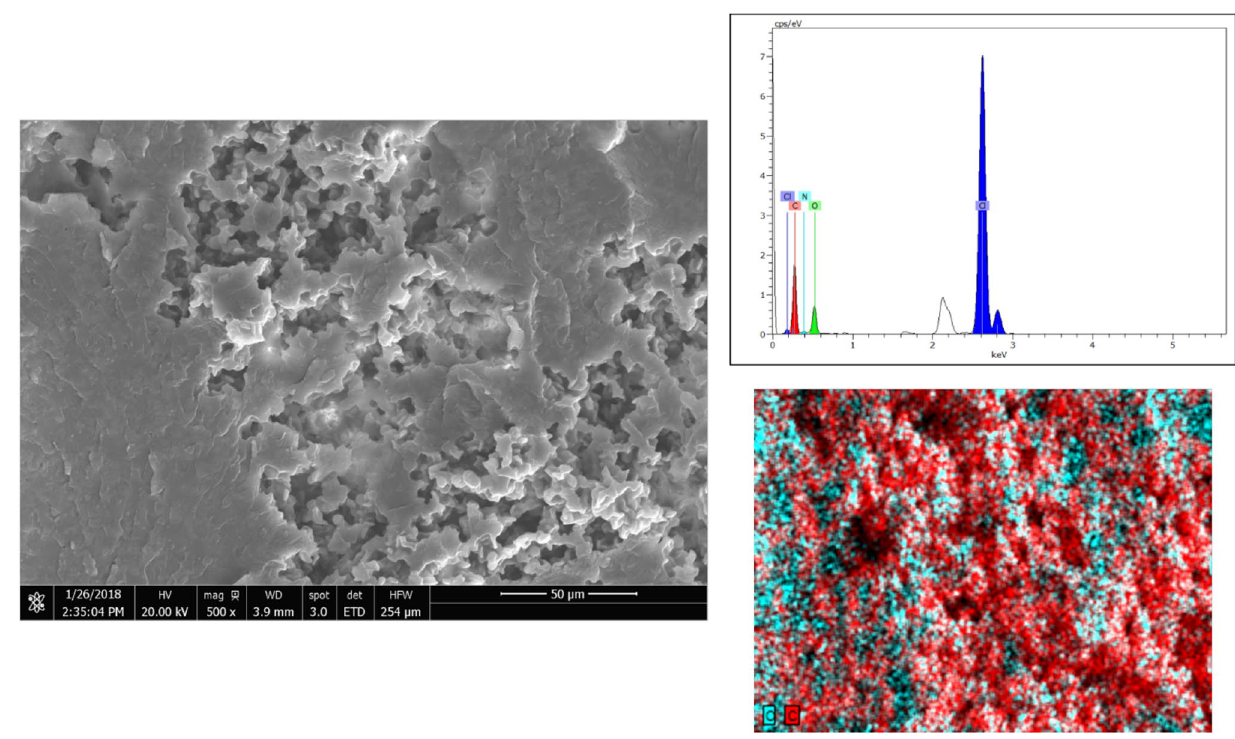
Fig. 9 SEM image, EDX spectra, and X-ray dot map of Cl and O Kα of the PU/PVDC film reinforced with 0.5% of CNC